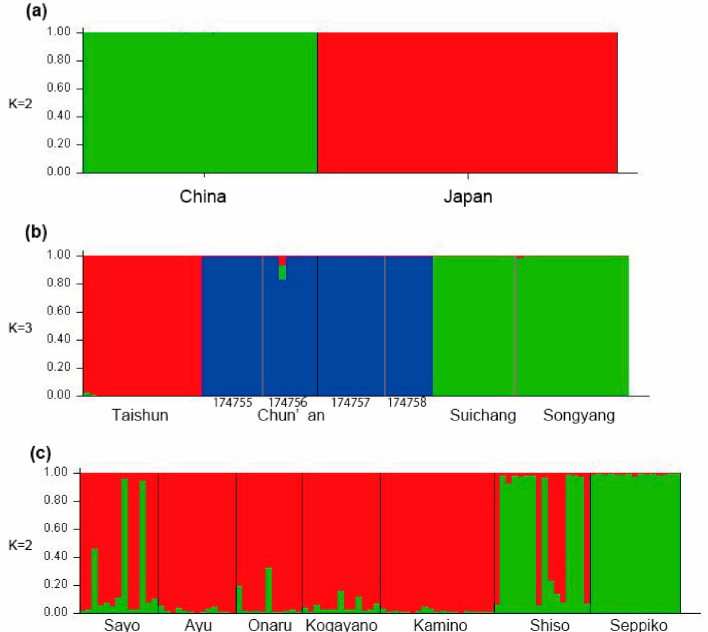
Figure 4. Results from a Bayesian population assignment test with STRUCTURE for Meehania montis-koyae based on 338 MIG-seq SNPs. ( a ) Chinese and Japanese individuals ( n = 178), ( b ) Japanese individuals only ( n = 100), ( c ) Chinese individuals only ( n =